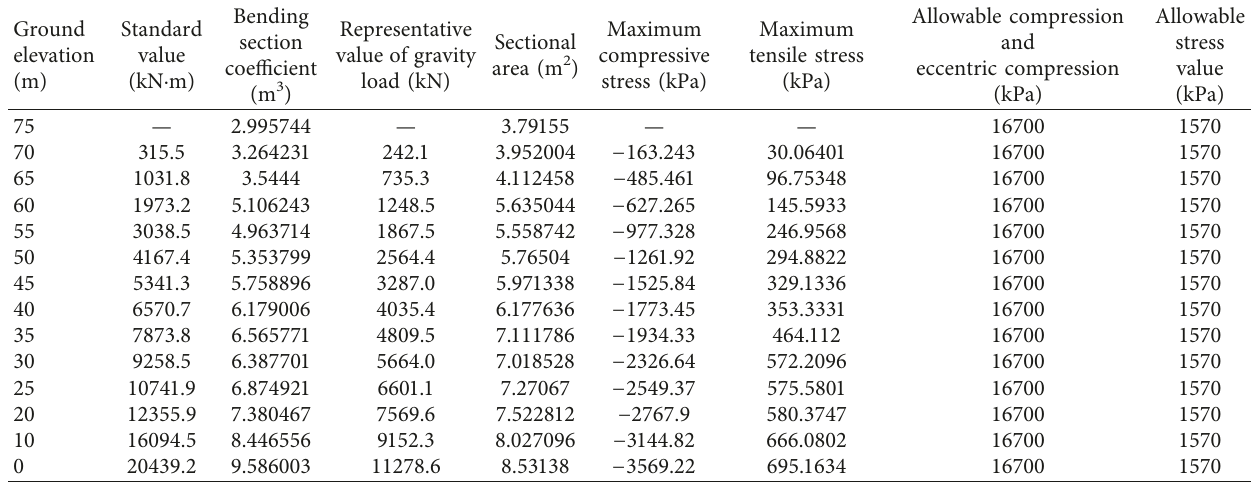
Table 11: Maximum stress values under the action of earthquakes and wind.